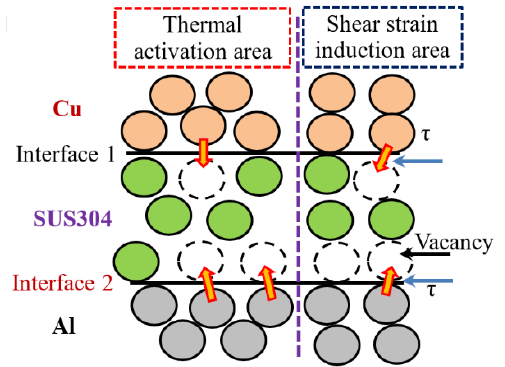
Figure 12. Schematic diagram of vacancy diffusion around the bonding interface.